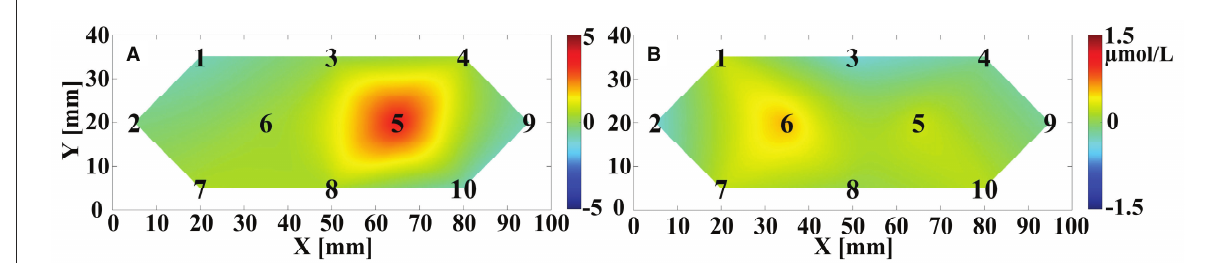
FIGURE10 The OT of averaged 1 [HbO] across the six repeated trials for participant 1 evoked by (A) MA and (B) MS after 15s from the onset of the task. The black numbers denote the position of the sampling channels. The vertical color bar indicates the range in µ mol/L.